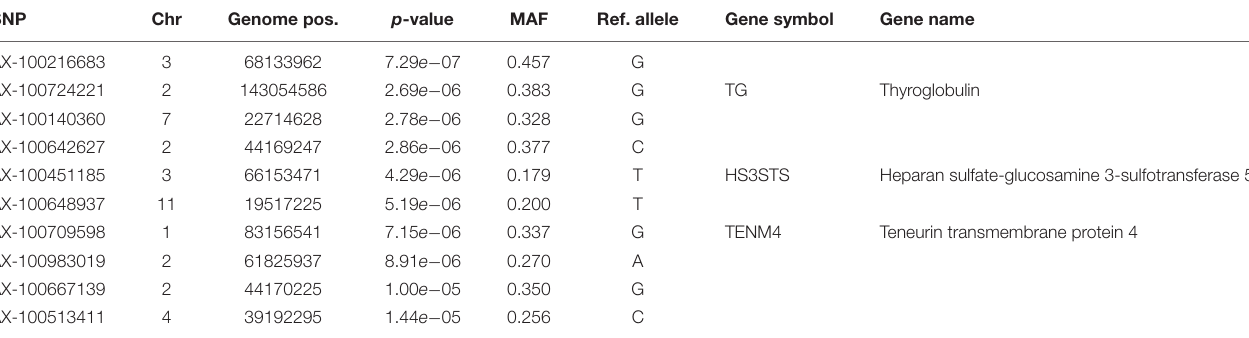
Given are SNP name, on which chromosome it is located (Chr), physical genome position in great tit reference genome (Genome position), p-values of GWA analyses, minor allele frequencies (MAF), reference allele and symbols and names of associated genes. Critical p-value after Bonferroni correction was 1.30e − 07. SNPs were assigned to genes based on their genomic position by using the great tit reference annotation (NCBI Parus major Annotation Release